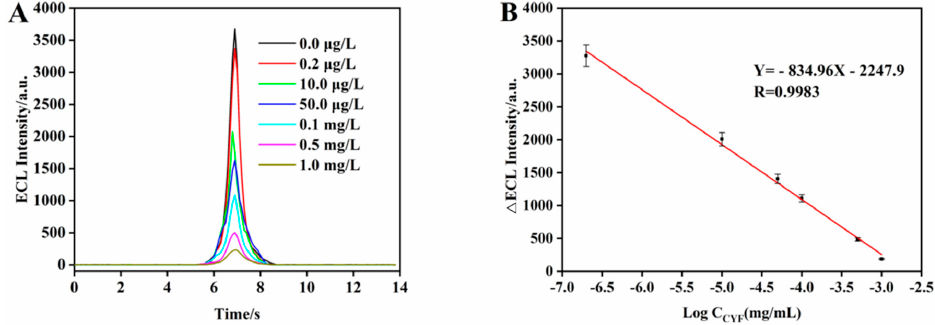
Figure 8. ( A ) ECL responses of the proposed MIECL sensor in the presence of various CYF Figure8. ( A )ECLresponsesoftheproposedMIECLsensorinthepresenceofvariousCYFconcentrations concentrations (0.2 µg/L, 10.0 µg/L, 50.0 µg/L, 0.1 mg/L, 0.5 mg/L, and 1.0 mg/L); ( B ) calibration curves (0.2 µ g / L, 10.0 µ g / L, 50.0 µ g / L, 0.1 mg / L, 0.5 mg / L, and 1.0 mg / L); ( B ) calibration curves of the MIECL of the MIECL sensor for CYF determination. sensor for CYF determination.